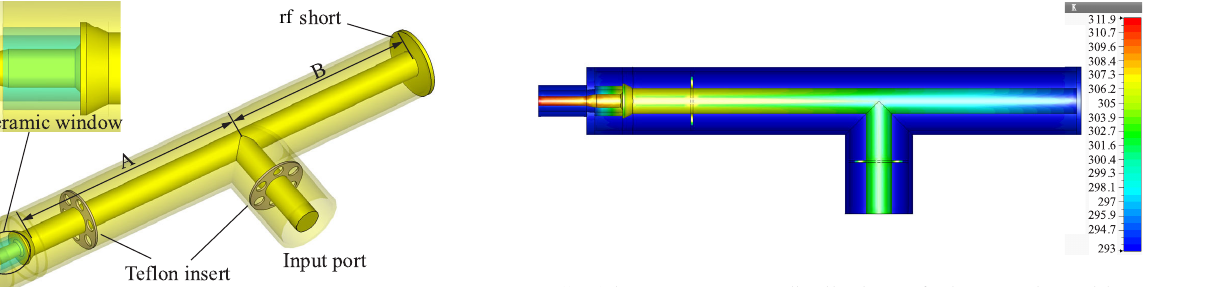
FIG. 35. Temperature distribution of the coupler without including the loop or any cooling.